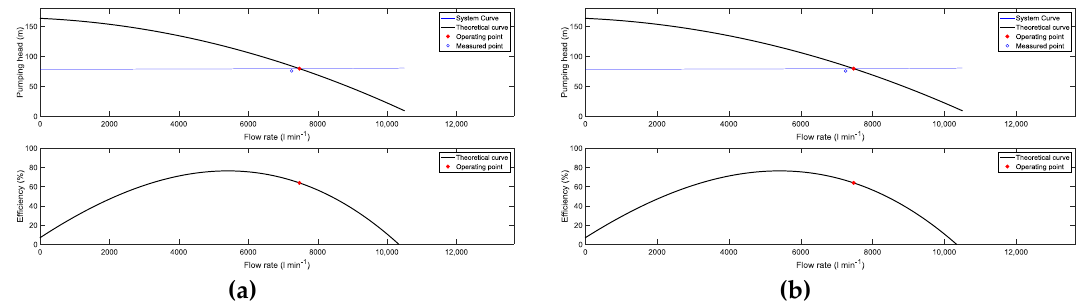
Figure 12. Operating point at fixed speed in WUA B for Case 2 in 2007 ( a ) and 2015 ( b ) irrigation